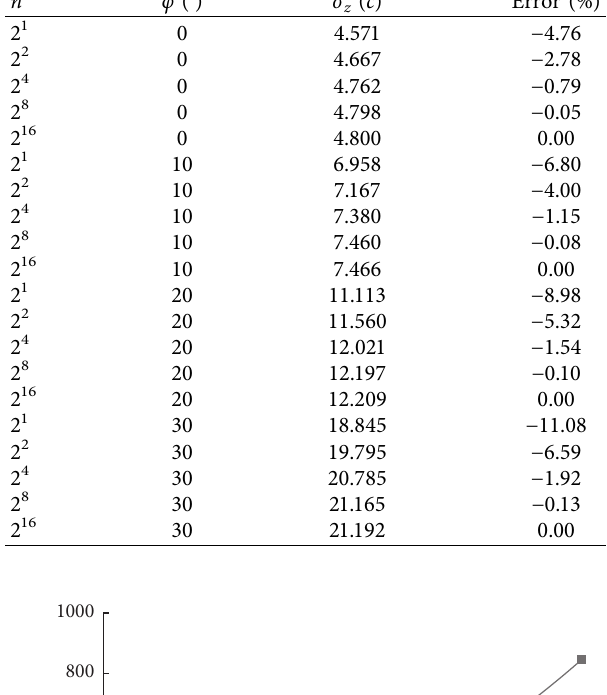
Table 1: Comparisons of lower-bound solutions with [15] ( σ N Stress column number (2 n +1) Ref. [15] This research